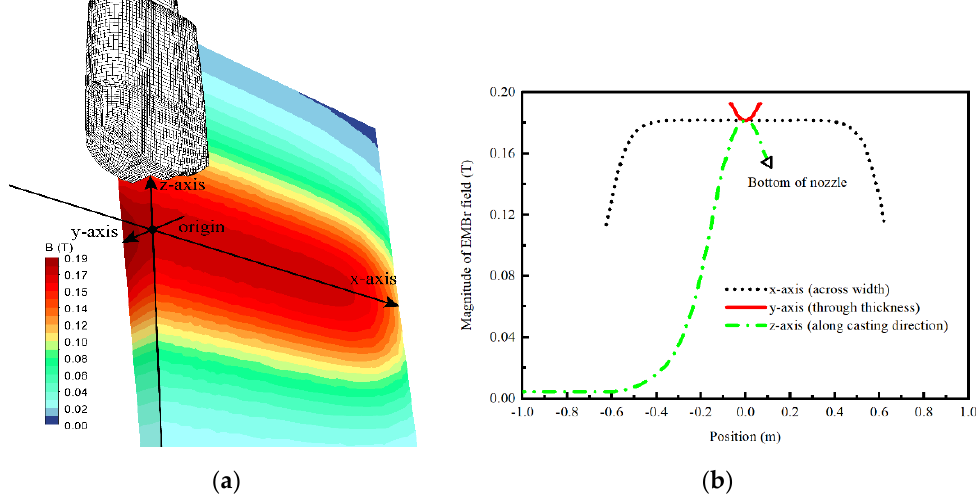
Figure 4. ( a ) Contour plot of the exterior magnetic field arising from the EMBr in one quarter of the mold. The x-, y-, and z-axis were along the direction of the width, thickness, and height of the mold, respectively. The origin had the same height as the pole center of the EMBr magnet. ( b ) Field strength in the three lines. The negative direction of the z-axis was the same as the casting